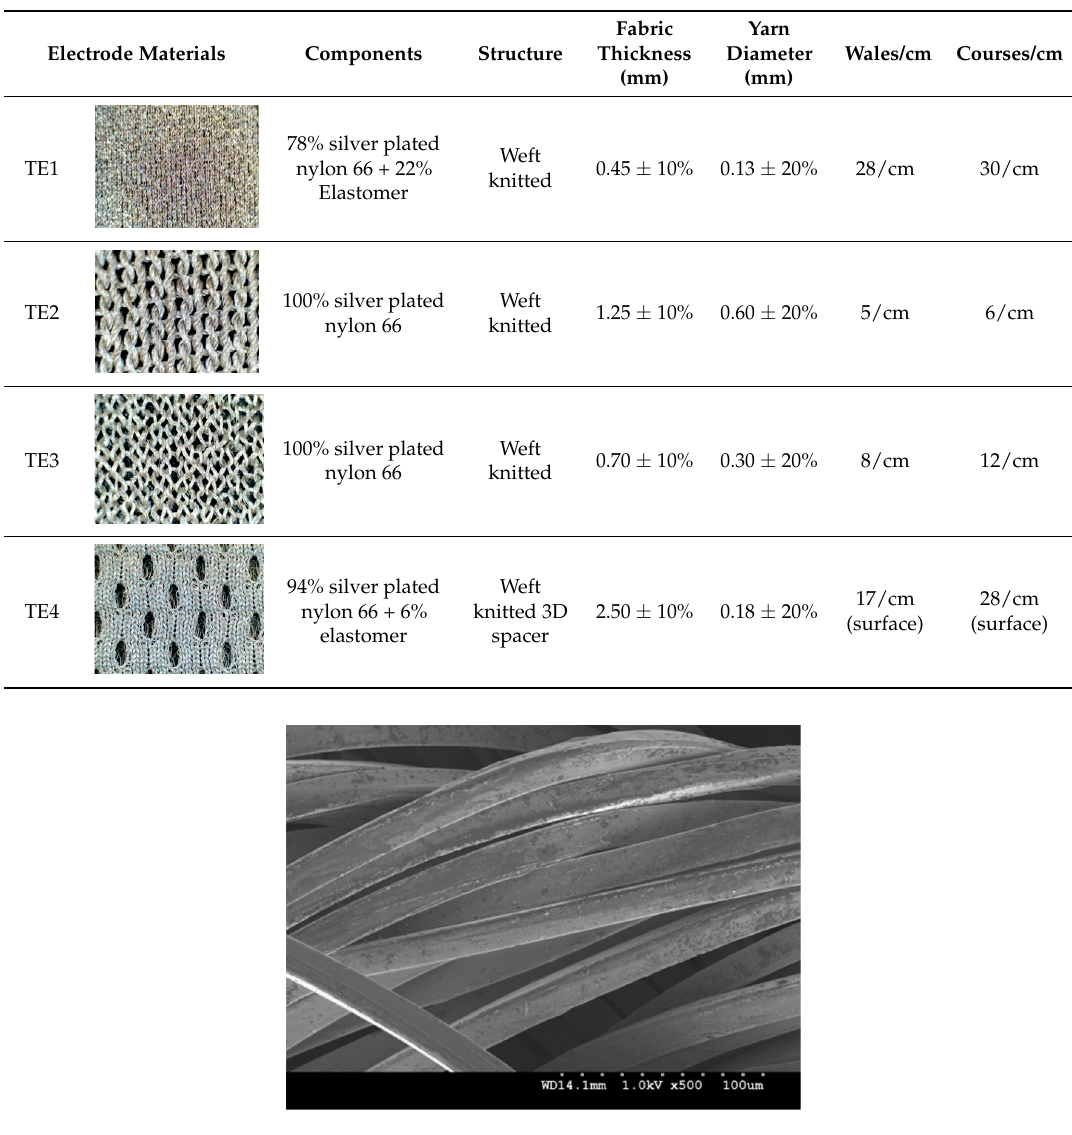
Figure 2. The scanning electron microscope (SEM) micrograph of a silver plated nylon yarn. Table 1 . The properties of the four selected conductive knitted fabrics.